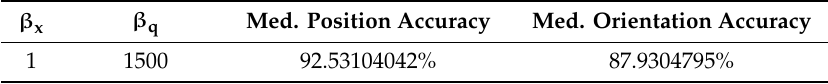
Table 12. Accuracy of the weighted Euclidean-based model (150,000 iterations).